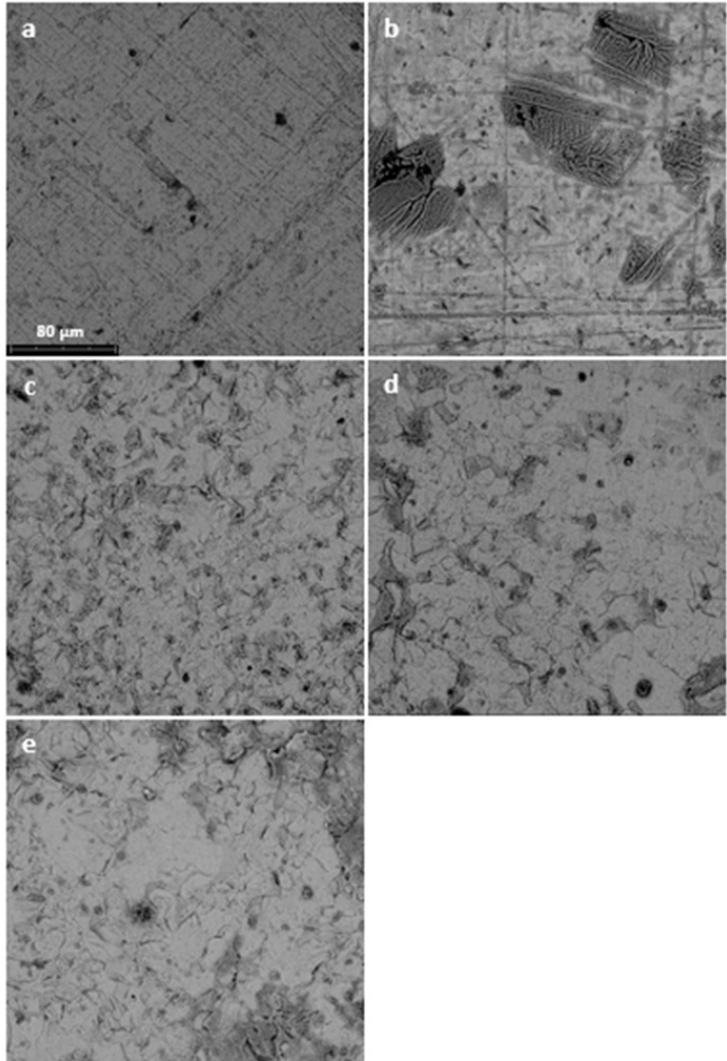
Figure 10. SEM backscattered electron images of mild steel surfaces in the a) absence and in the presence of b) 0.01 M, c) 0.03 M, d) 0.05 M and e) 0.07 M TTA exposed to 0.5 M HCl for 2